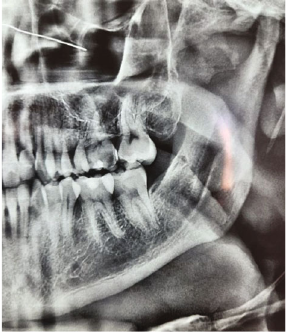
Figure 10: Portion of a 2021 control panoramic radiography focused on the old lesion